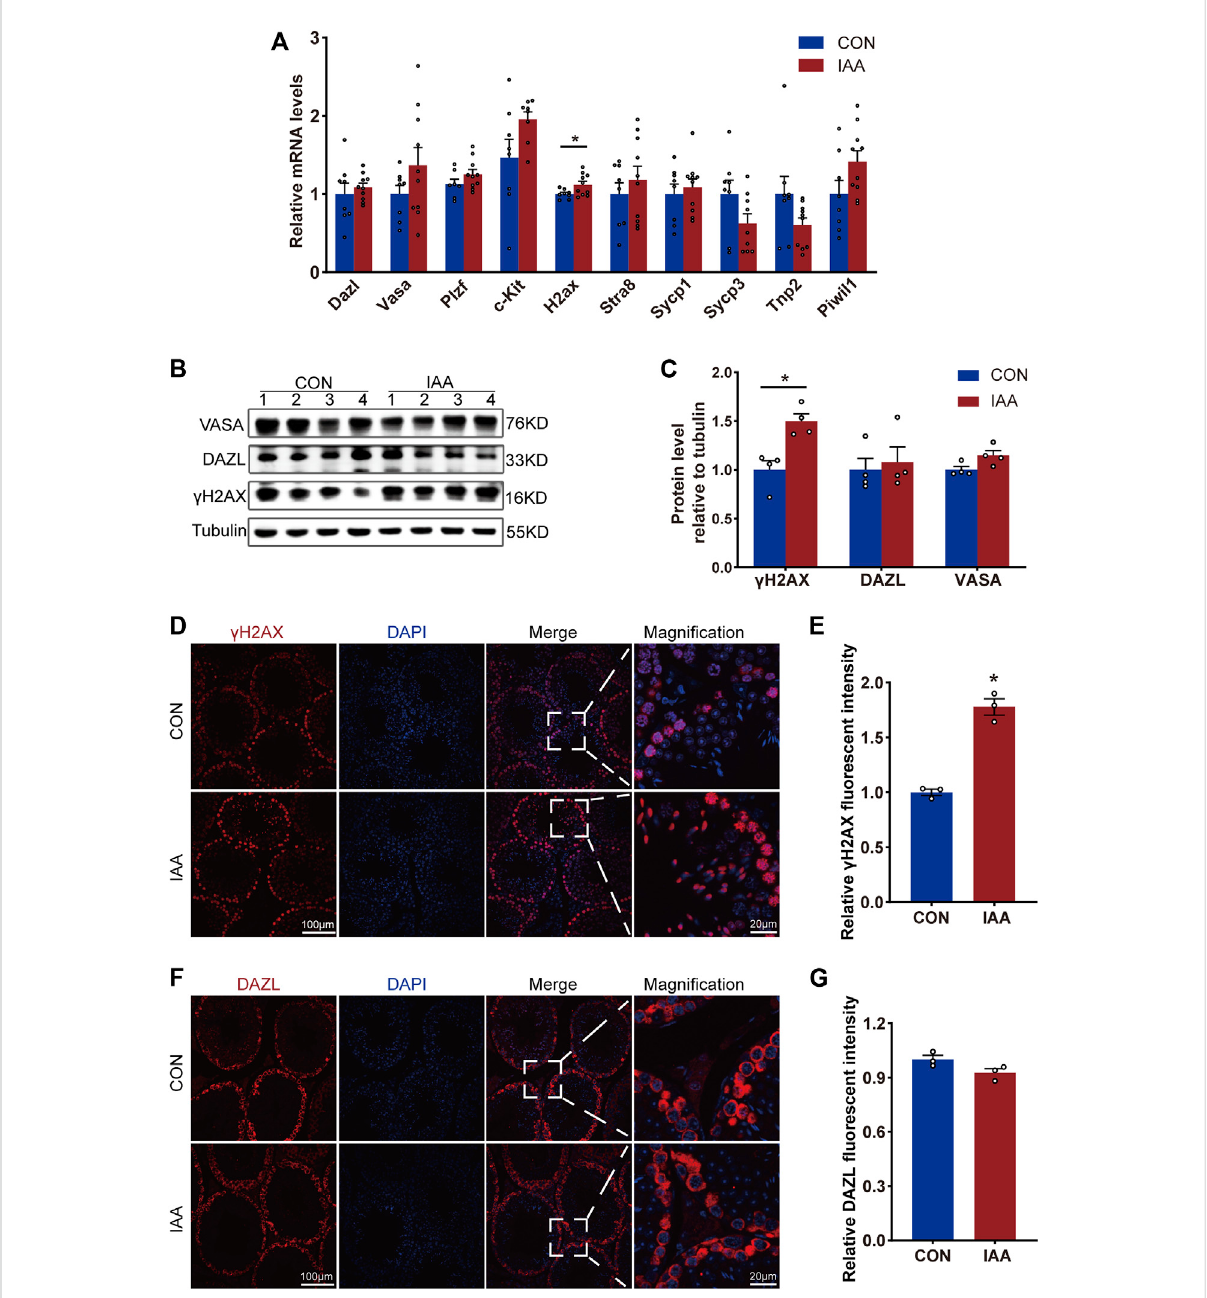
Changes of spermatogenesis-related indexes were observed from gene expression and protein level, respectively. The expression of the following genes, such as Dazl, Vasa, Plzf, c-Kit, H2ax, Stra8, Sycp1, Sycp3, Tnp2, and Piwil1, in the testis tissue of the two groups were detected by real-time PCR (qRT-PCR) technology (A) . Also, the changes of protein levels such as VASA, DAZL, and γ H2AX between the two groups of mice were observed by Western Blot (B,C) and immuno fl uorescence staining experiments (D – G) . * Signi fi cant differences compared to the control ( p <